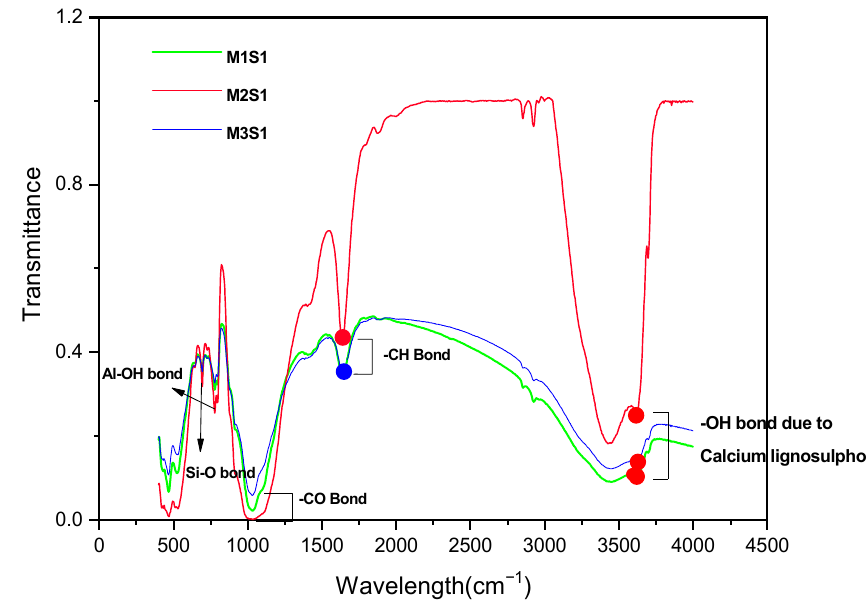
Figure 14. FTIR patterns of clay-GS mix in presence of 0.5% CLS.